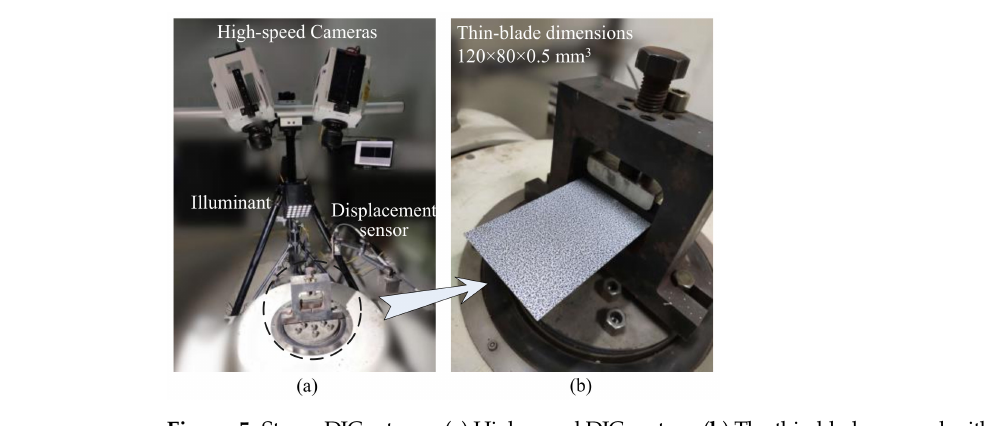
Figure 5. Stereo-DIC set-ups: ( a ) High-speed DIC system; ( b ) The thin-blade covered with speckle patterns.